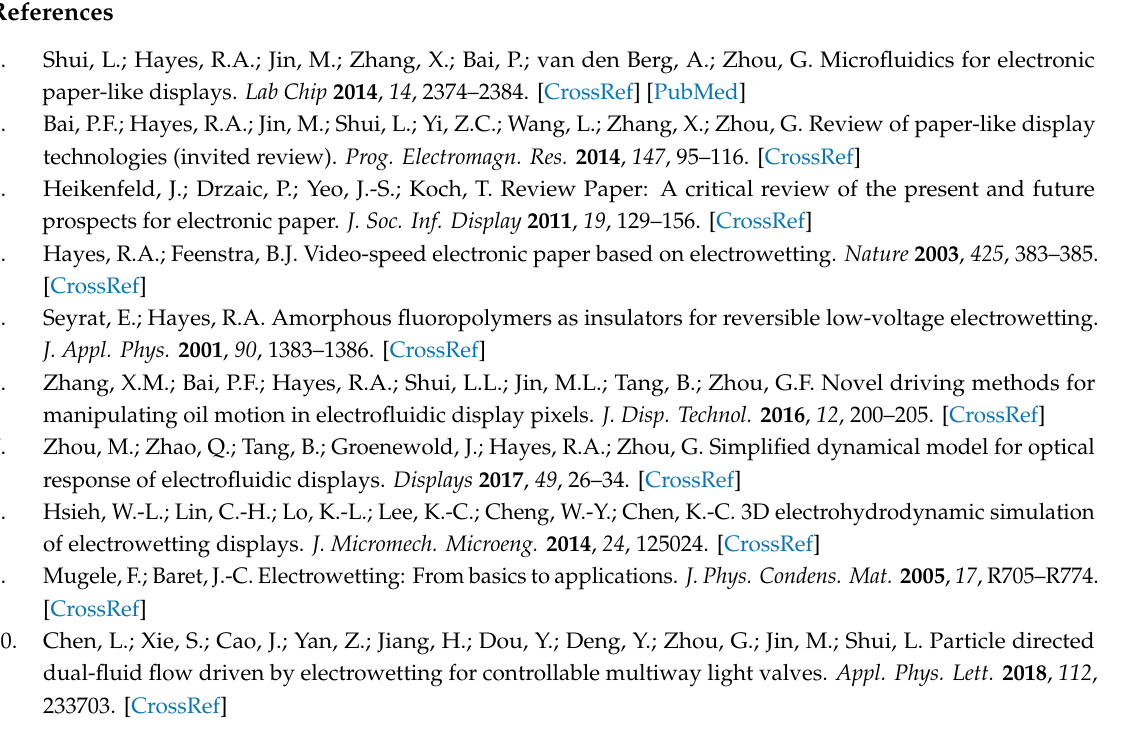
Figure S1: The graphs showing the oil states of pixels with di ff erent SAs parameters with time at switching-on